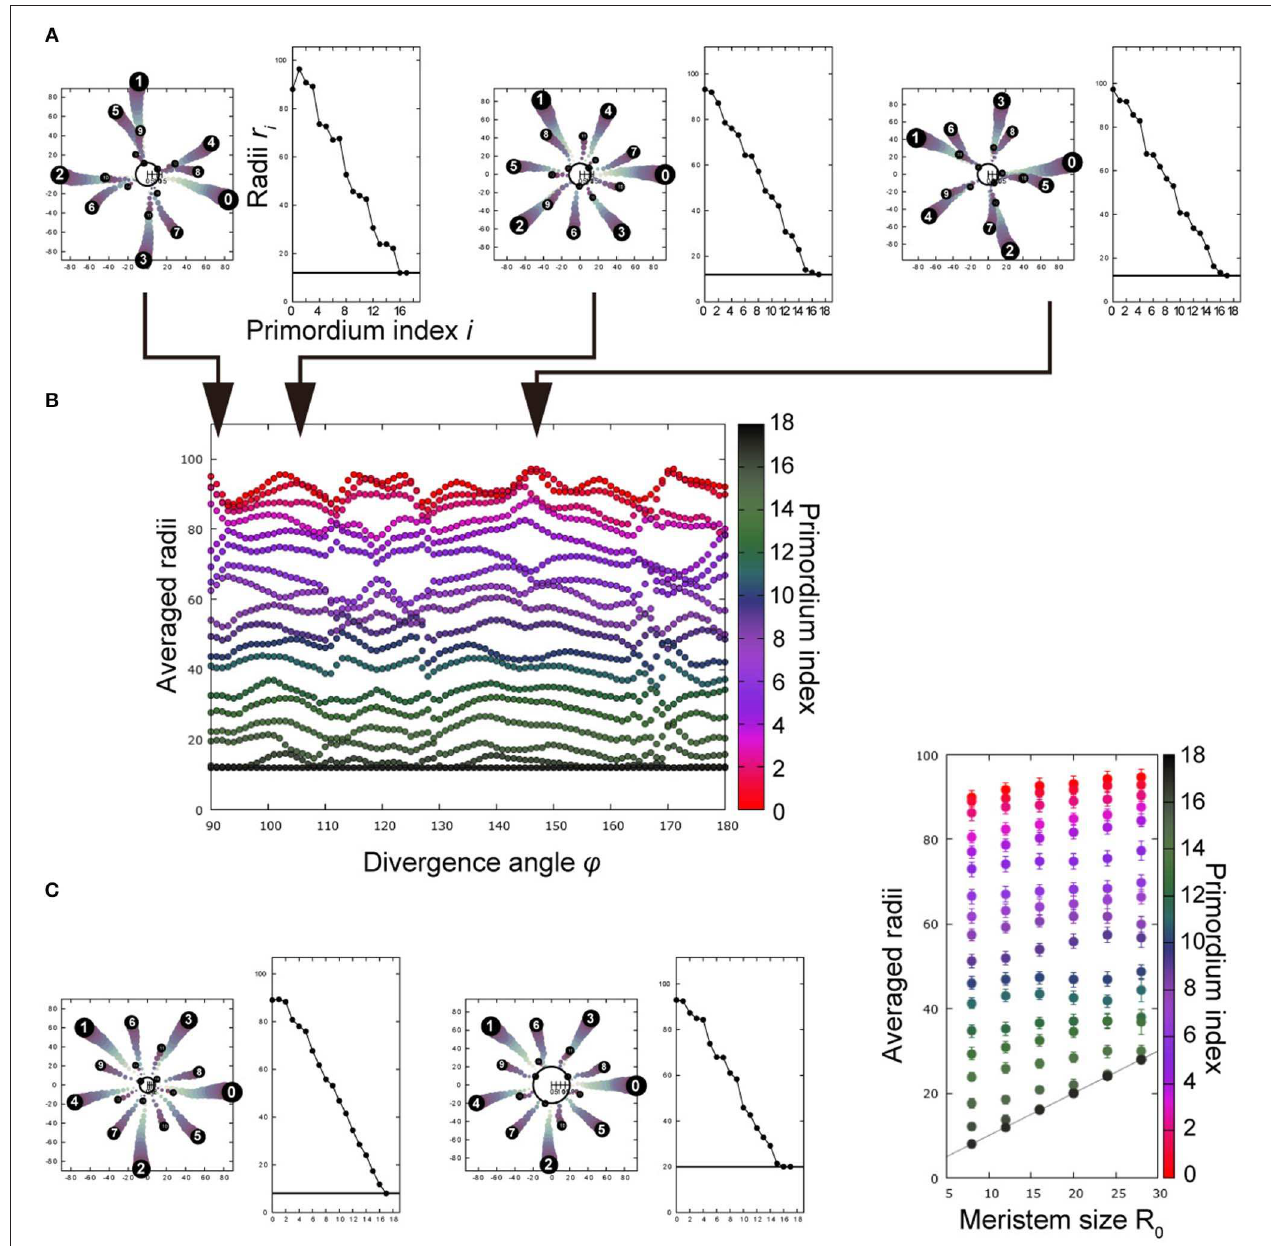
FIGURE 4 | Post-meristematic organ displacement after spiral initiation promotes radial symmetries of trimerous, tetramerous, and pentamerous whorls depending on divergence angles. (A) A representative result of Monte Carlo simulation, showing five trimerous whorls. The left panel shows the arrangement in a 2D plane whereas the right panel shows radial positions as a function of primordium indices, evidencing the trimerous whorls separated by radial gaps. φ = 91 ◦ (left), 108 ◦ (middle), and 145 ◦ (right); R 0 = 12.0. (B) Radii as a function of φ . Radii of primordia were averaged over 200 replicates at the timing of the 18th primordium initiation, and a file was obtained for each φ . The color scale indicates the primordium index. The vertical space corresponds to the radial gap between whorls, and the number of primordia separated by the spaces corresponds to the merosity. R 0 = 12.0. (C) Dependence on the R 0 at φ = 136 ◦ . The merosity of the outermost whorl changed from trimery (left, R 0 = 8.0) to pentamery (middle, R 0 = 20.0), as R 0 increased. The averaged radii are shown in the right panel as in (B) , where error bar denotes the standard deviation of 200